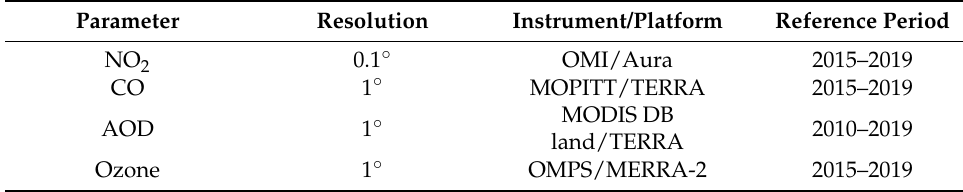
Table 1. Data products and their reference periods. Parameter